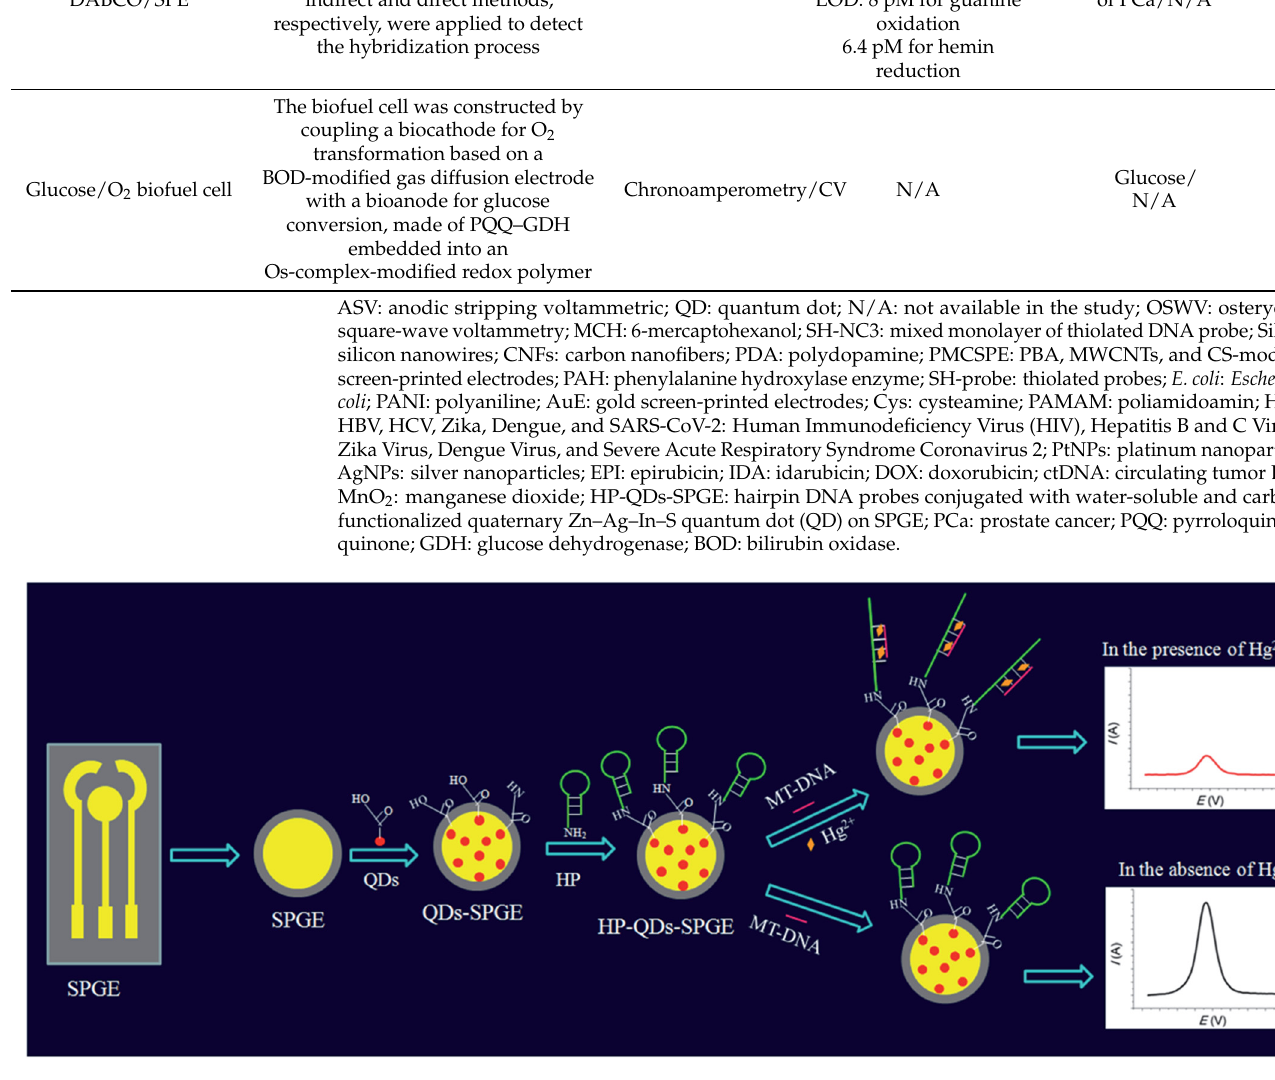
Figure 5. Schematic representation of the HP–QDs–SPGE electrochemical biosensor (adapted and reprinted with permission from [79]).